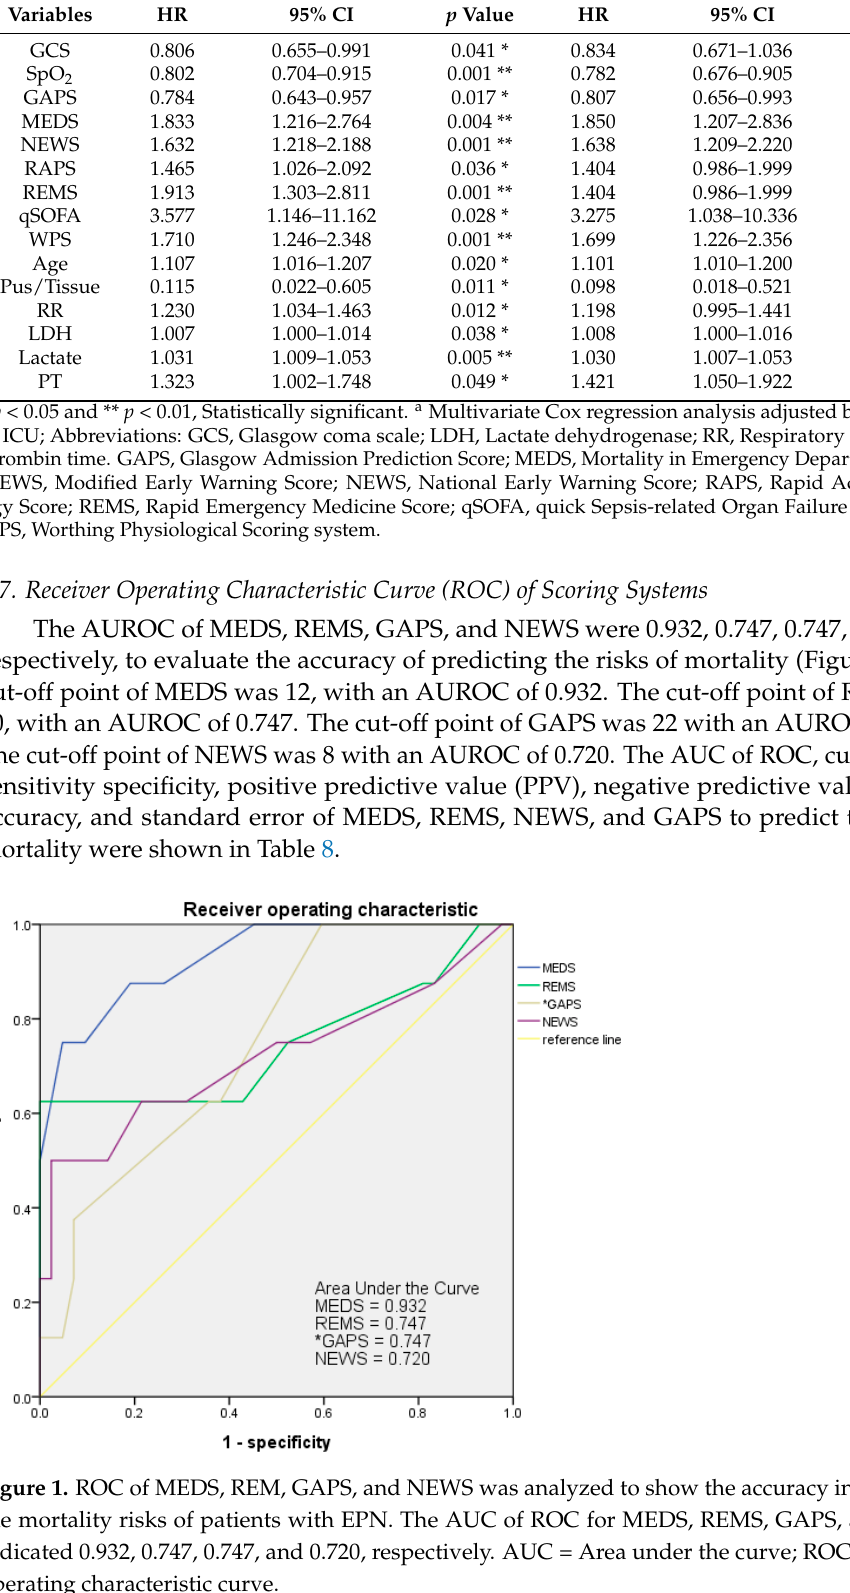
Table 7. Hazard ratios and 95% confidence interval of univariate analysis and multivariate Cox regression analysis.